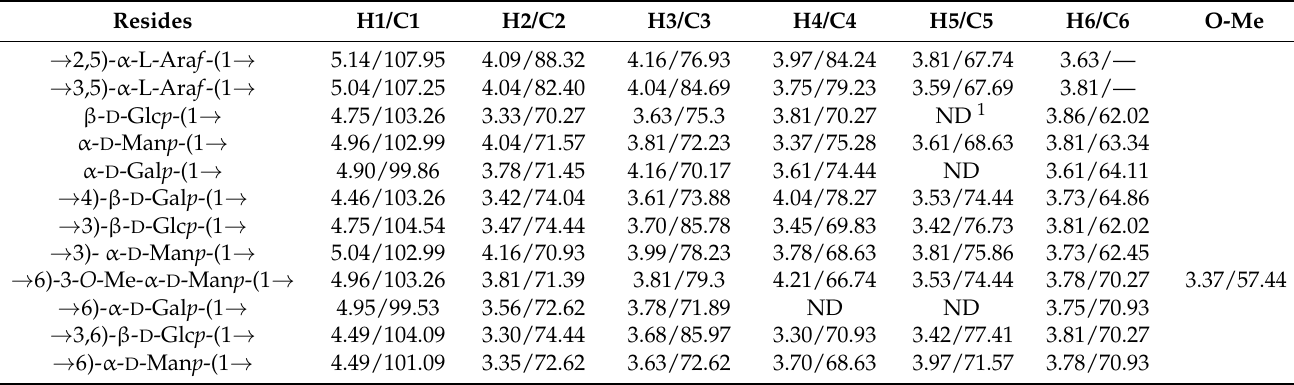
Table 3. 1 H and 13 C NMR chemical shifts of Tmp ( δ ,